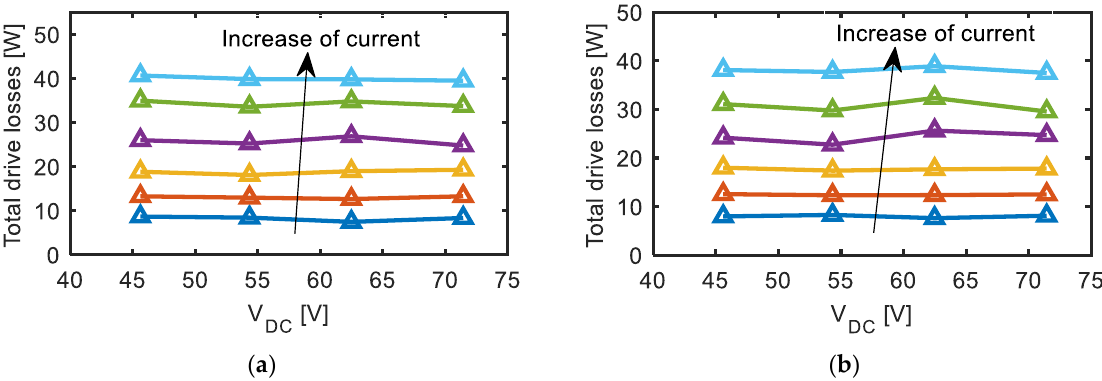
Figure 11. The drive total losses at different DC-link voltages and different motor currents and current angles of ( a ) 50° and ( b ) 25°.